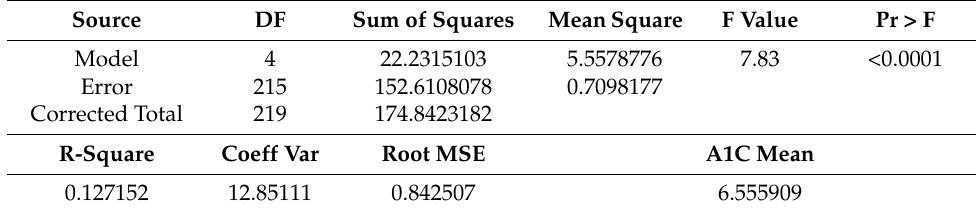
Table A2. GLM with A1C as dependent